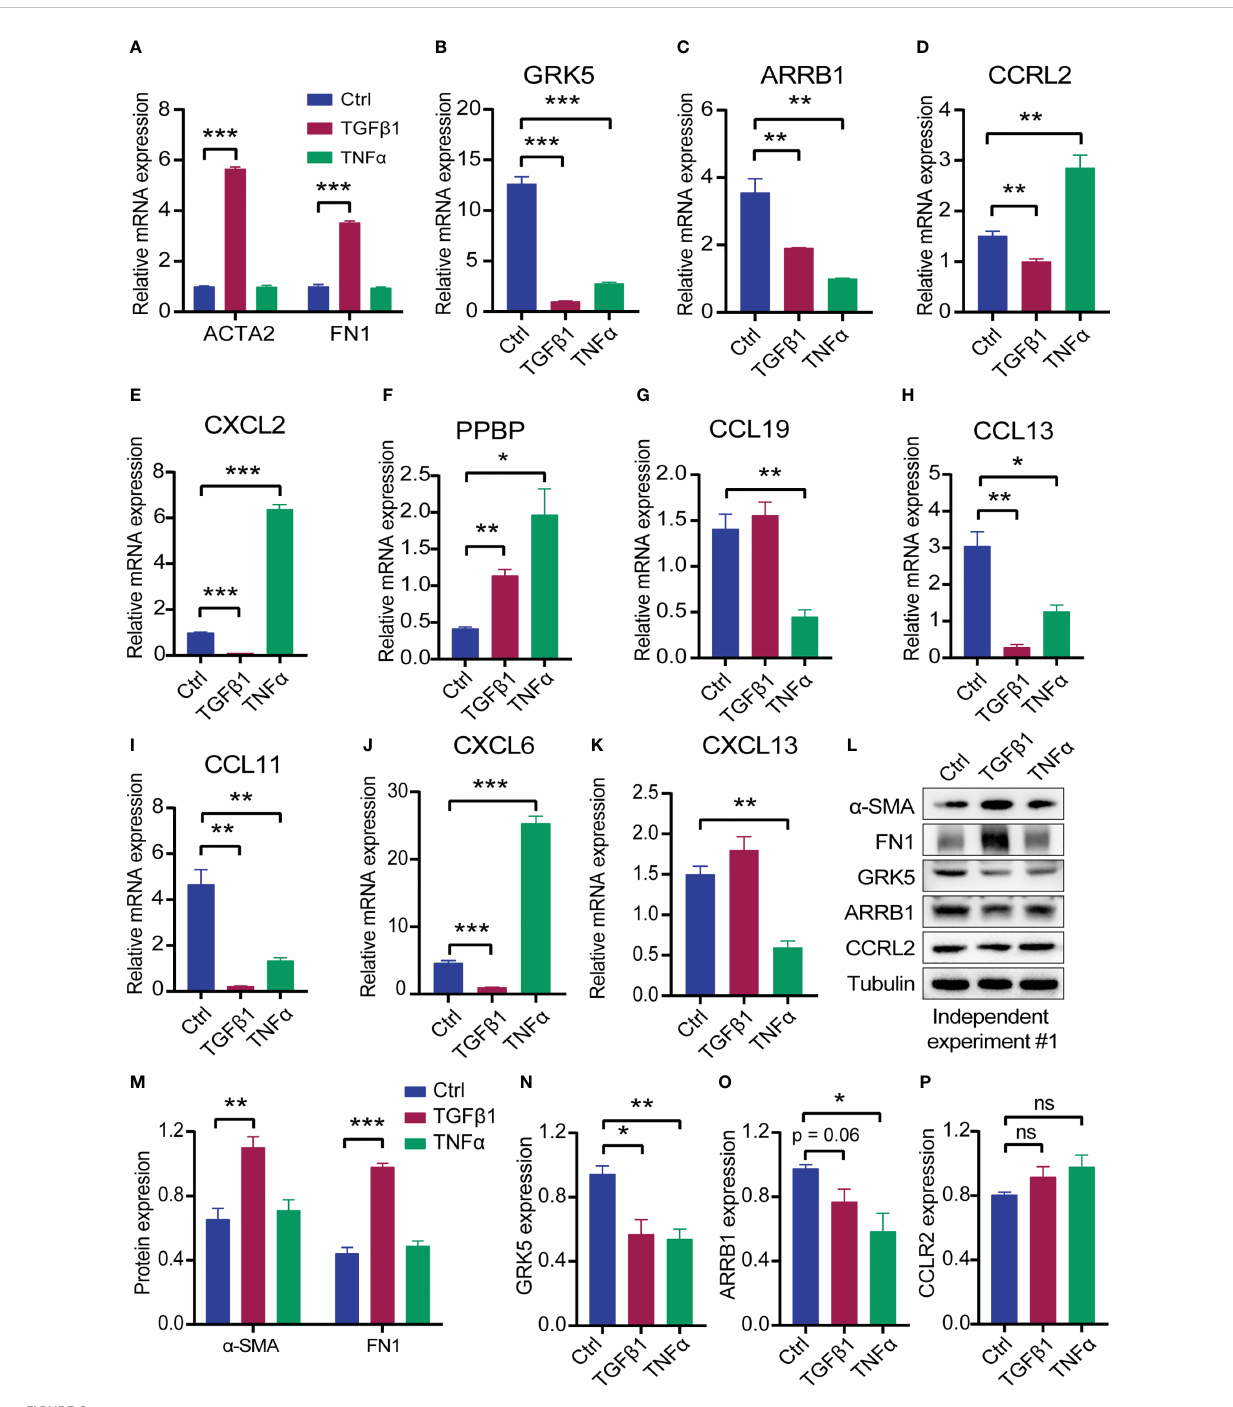
FIGURE 8 The expression of the eleven CR-DEGs in MRC-5 treated with TGF b 1 or TNF a for 24 h. (A) mRNA levels of ACTA2 and FN1 in control, TGF b 1, and TNF a group. (B – K) mRNA levels of CXCL2 (B) , CCRL2 (C) , ARRB1 (D) , GRK5 (E) , PPBP (F) , CCL19 (G) , CCL13 (H) , CCL11 (I) , CXCL6 (J) , and CXCL13 (K) in control, TGF b 1, and TNF a group, (L) Protein levels of a -SMA, FN1, GRK5, ARRB1, and CCRL2. (M-P) Quantitative analysis of a -SMA, FN1 (M) , GRK5 (N) , ARRB1 (O) , and CCRL2 (P) . Values were expressed as mean ± SEM, *p < 0.05, **p < 0.01, ***p < 0.001. t test was used. Ctrl, control; ns, not signi fi cant